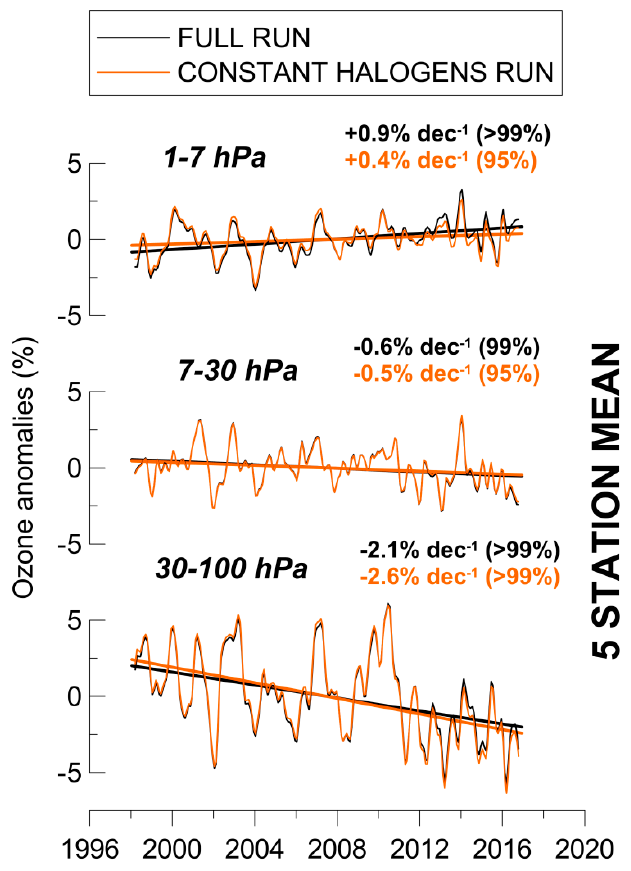
Figure 4. Oslo CTM3 simulations of stratospheric ozone. Black line shows trends derived from the main simulation (FULL); orange line shows trends derived from the simulation with constant halogens at 1998 levels. Values in parentheses refer to statistical significance of each trend. Five stations are HHP–OHP–TMO–MLO–LAU. Variability related to the seasonal cycle and dynamical proxies is removed from the data.